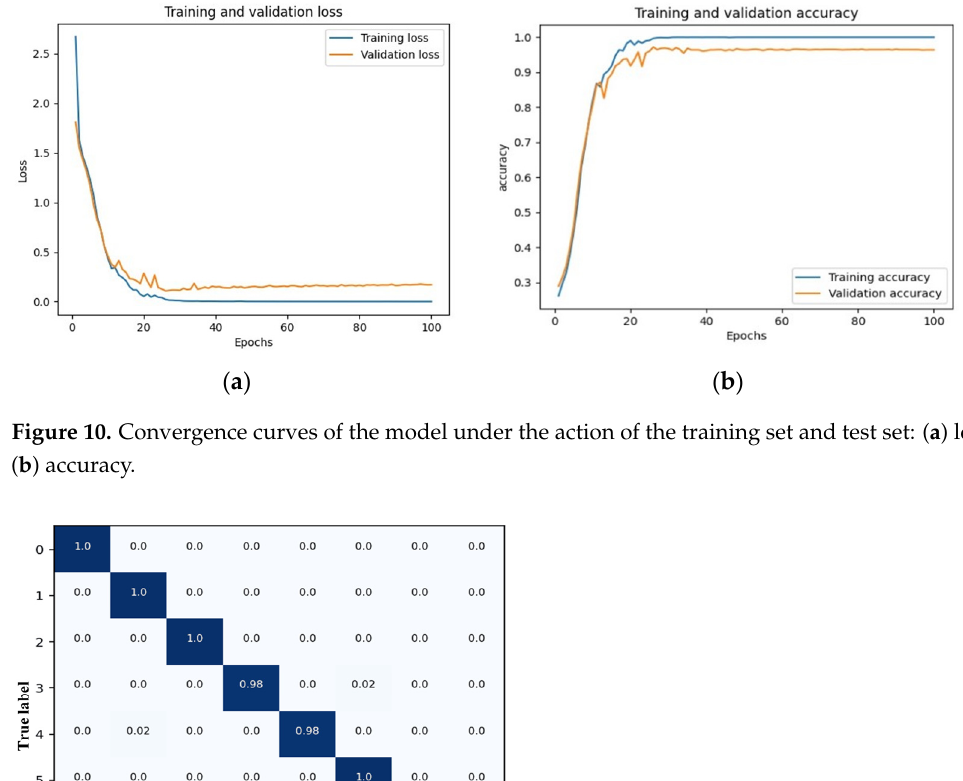
( b ) Figure 12. Clustering effect of different convolution layers under T-SNE: ( a ) first layer; ( b ) fifth layer. Figure 13. Feature vector output of the first convolution layer.